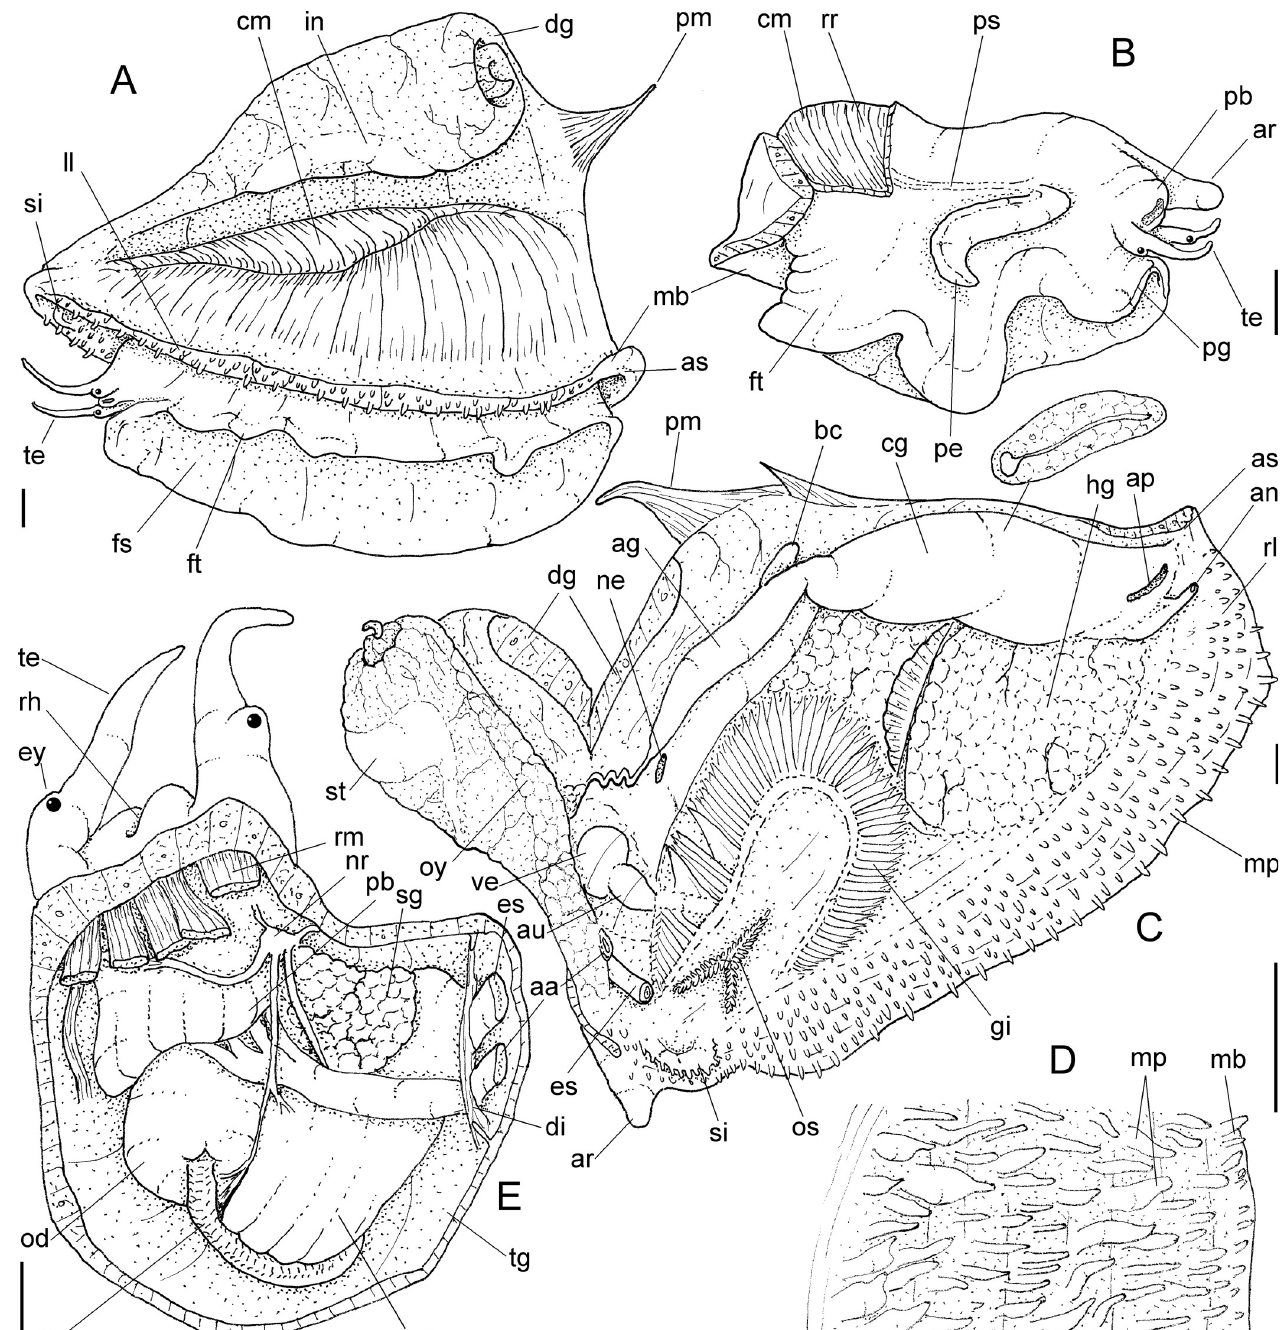
Fig 8. Macrocypraea cervus anatomy. (A) Whole specimen extracted from shell, left view, visceral mass slightly deflected upwards. (B) Head-foot, male, right view.; (C) Pallial roof and visceral mass, ventral view, portion of gill ventral to pericardium removed, anterior region of digestive gland (dg) and hypobranchial gland (HG) partially sectioned transversally, transverse section of indicated region of capsule gland (cg) also shown. (D) Right mantle lobe, middle region, outer view. (E) Head, ventral view, foot and columellar muscle removed. Scales = 5